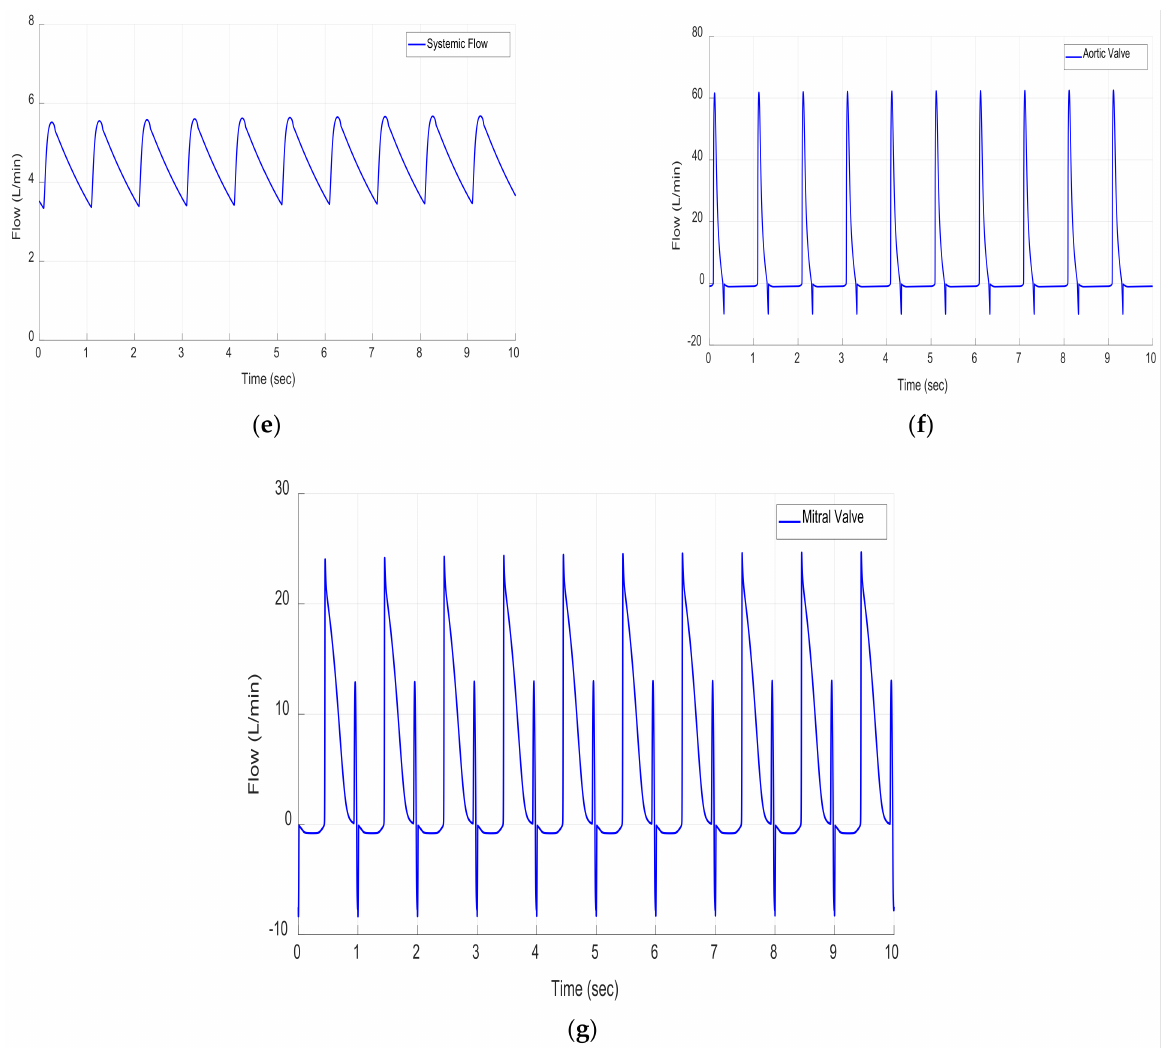
Figure 4. Hemodynamic variable results for the rest condition; ( a ) left ventricle pressure; ( b ) aortic pressure; ( c ) left atrium pressure; ( d ) left ventricle volume; ( e ) systemic flow; ( f ) aortic valve flow; ( g ) mitral valve